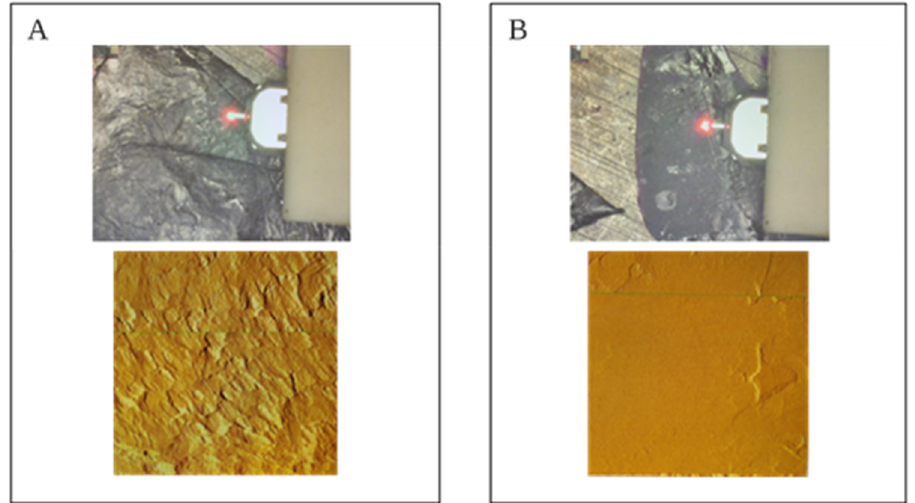
Figure 2. Details of the indentation done with the atomic force microscopy (AFM) on treated skin ( A ) and untreated skin ( B ) are seen in the top images, and the details on the roughness of the skin are seen on the bottom images.